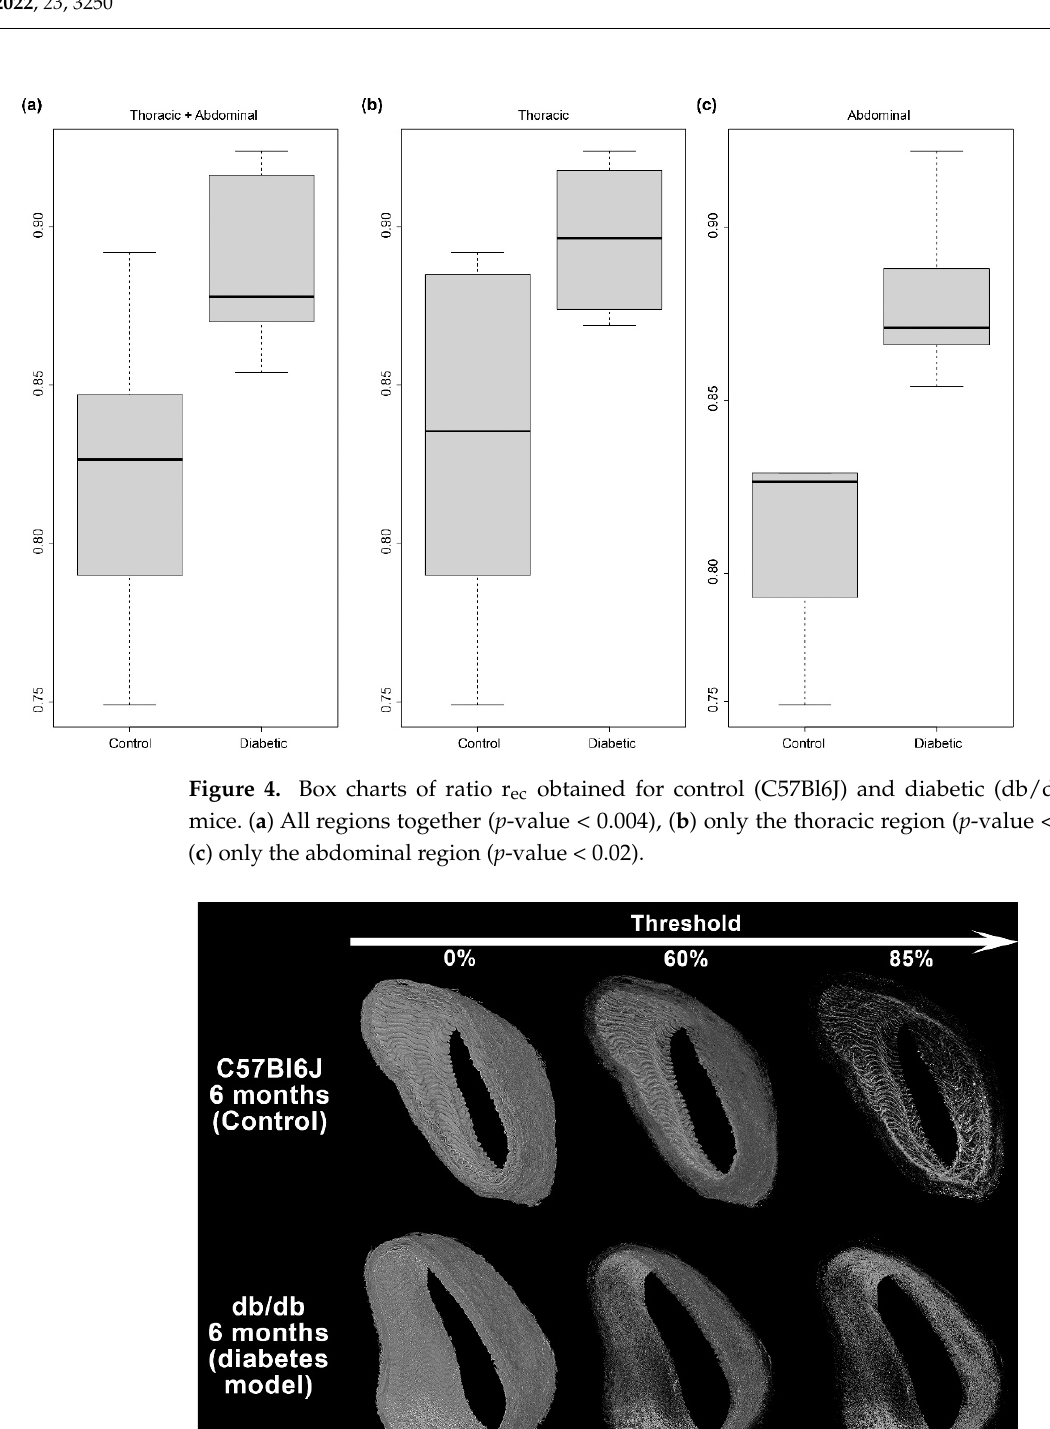
Figure 5. Lattice-like filamentous networks of 6-month-old mice. Typical 3D reconstruction of synchrotron X-ray micro-CT acquisition of C57Bl6J mouse (upper images row) and db/db mice (lower images row). Stacks are limited to 800 planes for convenient visualization. To compare structural details, the samples are the same as in Figure 2. Voxel intensity threshold increases from left to right to reveal the underlying lattice-like network (C57Bl6J, upper line) or its absence (db/db, lower line). Largest lumen diameter: 670 µ m (C57Bl6J) and, respectively, 730 µ m